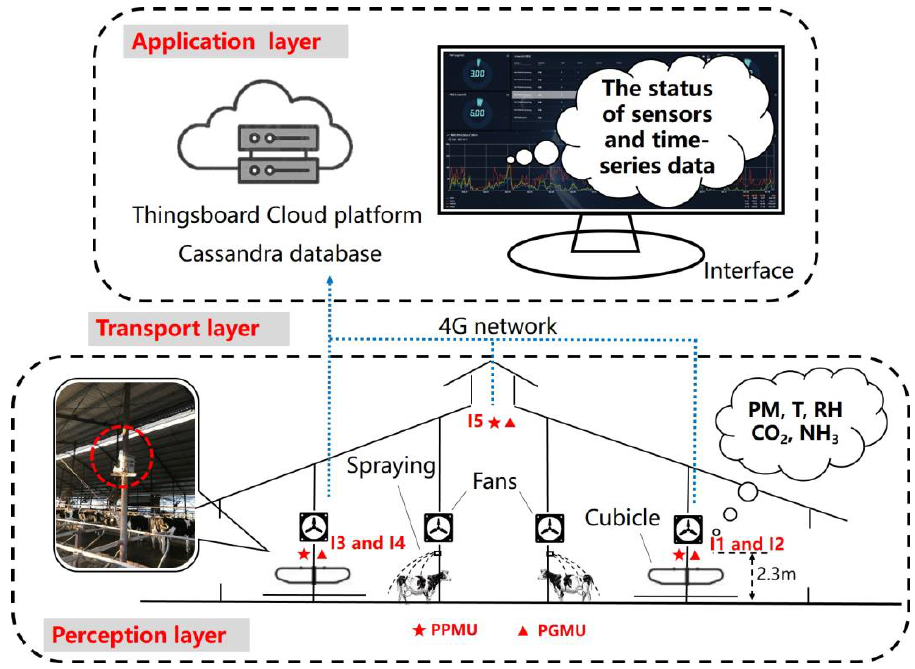
Figure 1. Schematics of the Internet of the Things (IoT) system framework of sensor monitoring network for dairy barns